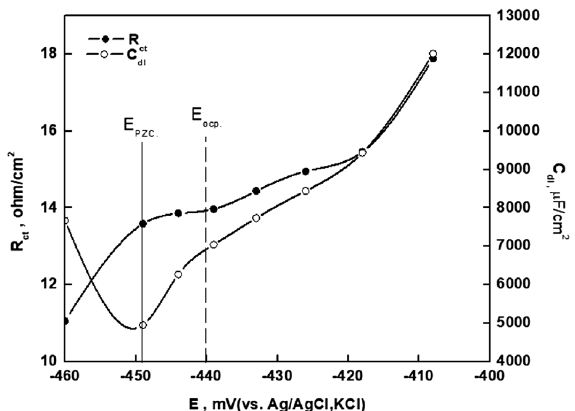
Figure 6. Variation of R ct and Q dl with the applied potential around the open circuit potential (− 440 mV) for steel in 20% phosphoric acid